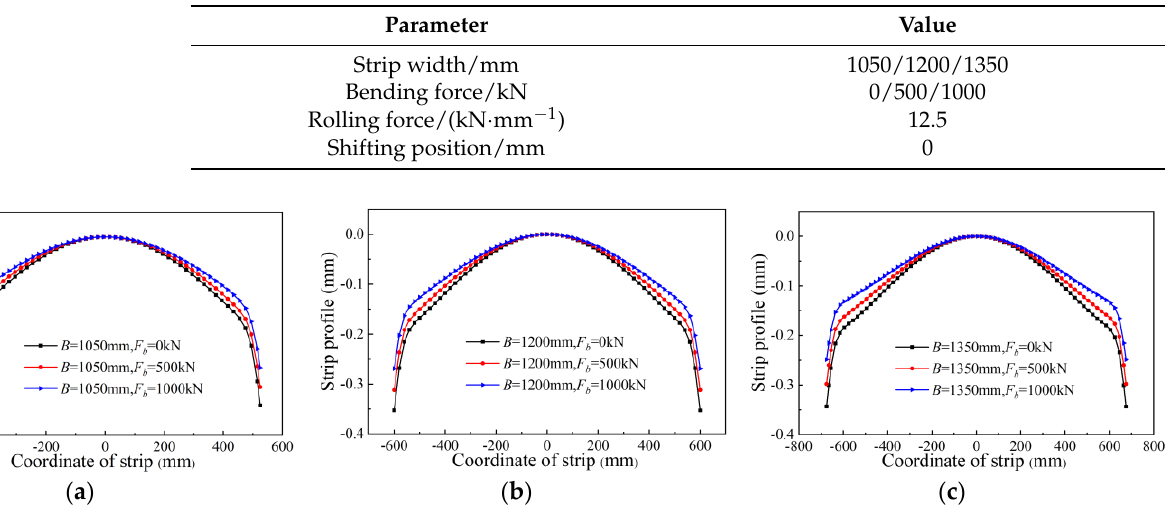
Table 6. Simulation condition of the influence of bending force on strip crown.